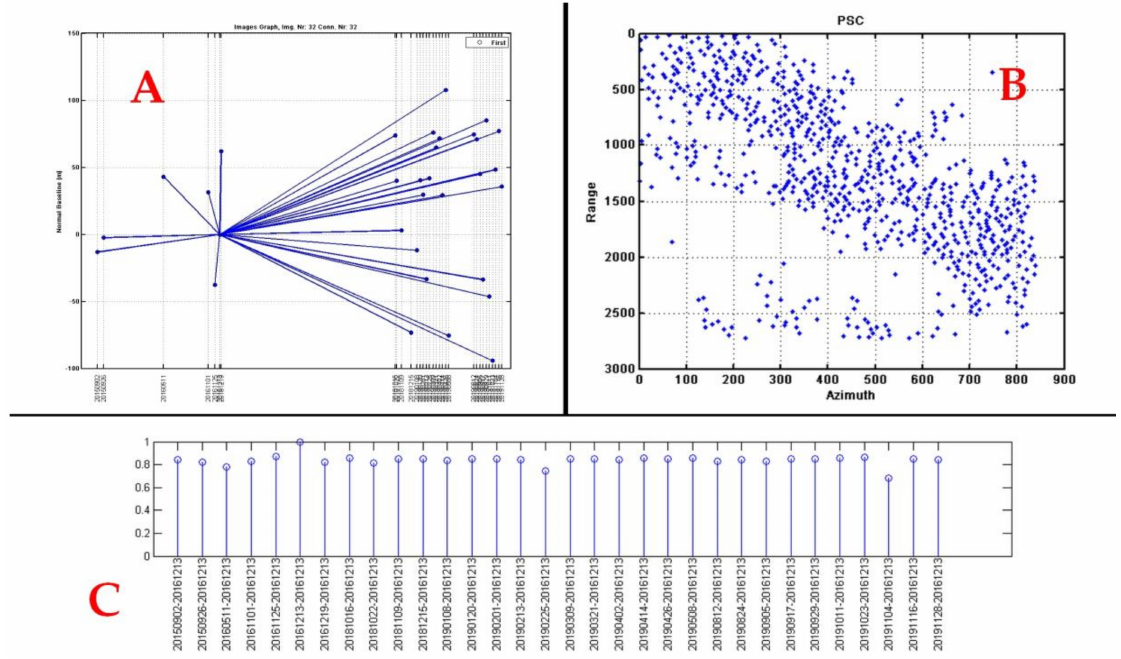
Figure 4. ( A ) Graph showing Sentinel 1 dataset analyzed in the normal baseline-temporal space, where each point and line represents an image and an interferogram, respectively. ( B ) Plot of sparse point selection. ( C ) The number of images in the stack with coherence greater or equal to